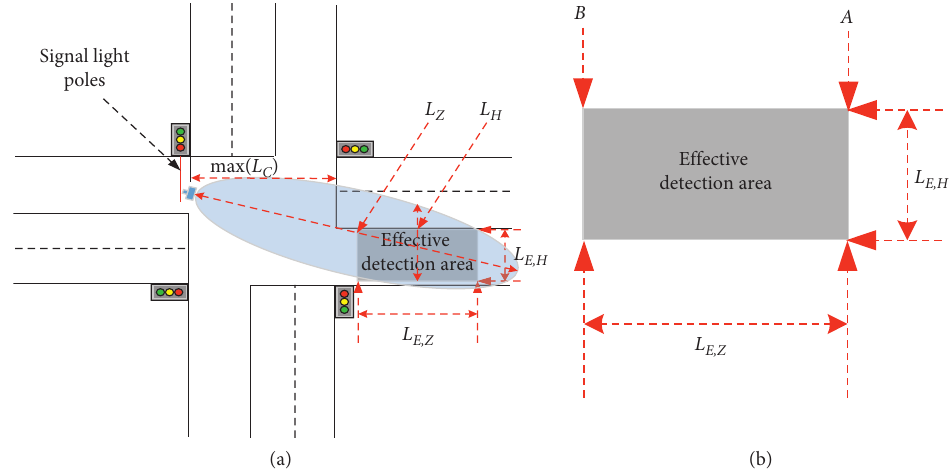
Figure 4: Wide-area radar detection settings: (a) the location of wide-area radar detector and (b) effective detection